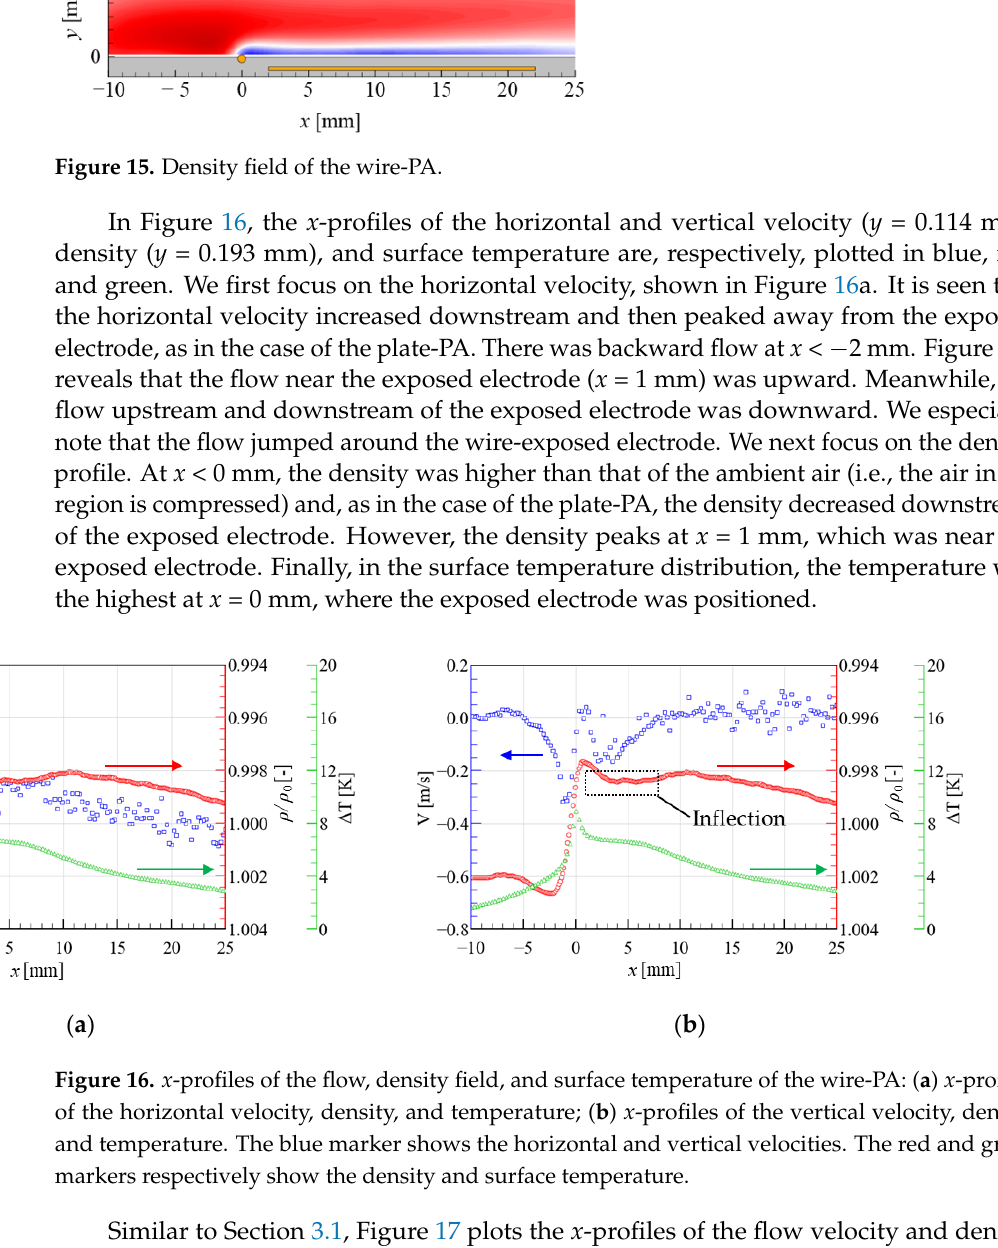
Figure 14. Flow velocity field of the wire-PA, obtained by PIV: ( a ) streamlines and the horizontal velocity; ( b ) streamlines and the vertical velocity.